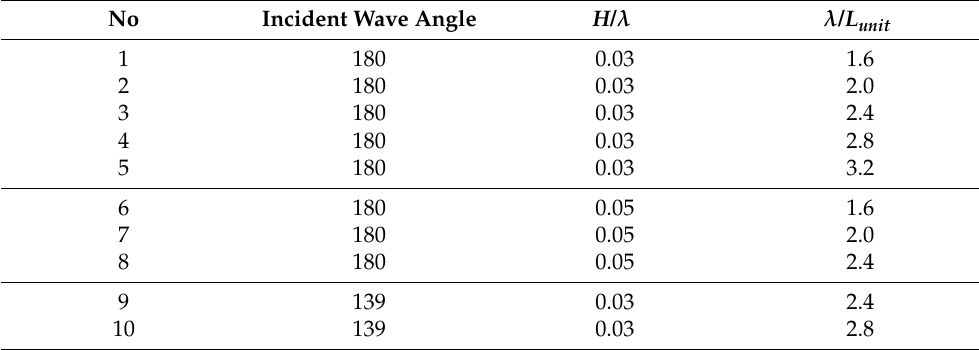
Figure 9. Computation setup of mooring lines (catenary) and the hinge system. Table 3. Test conditions of computation.